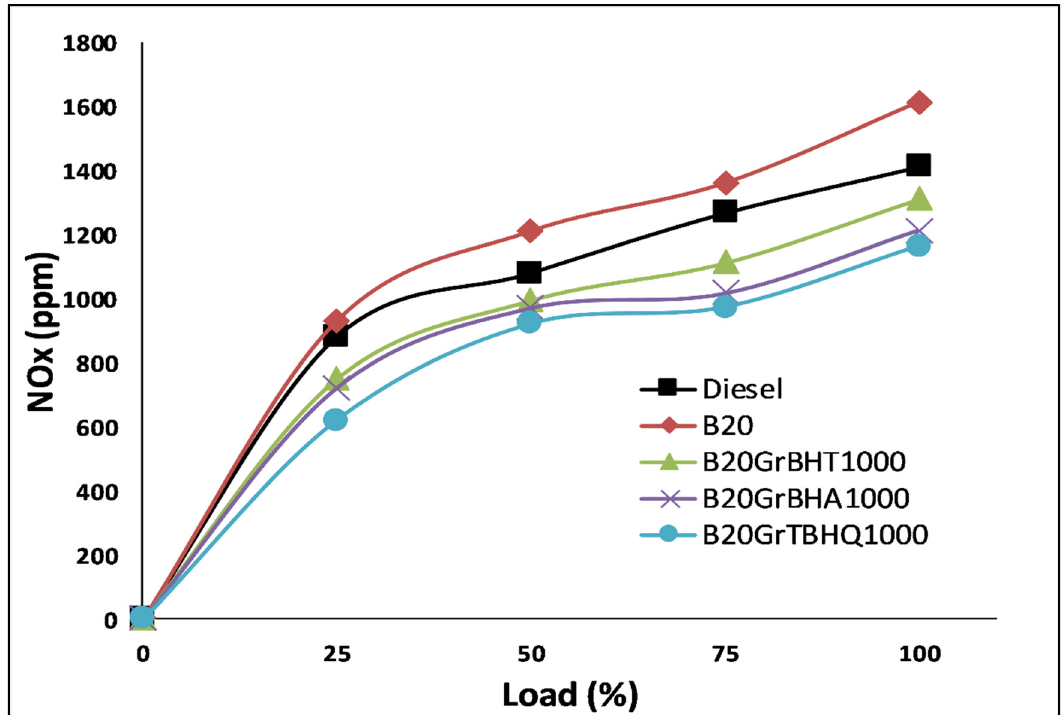
Figure 11. NO X emission with loading.